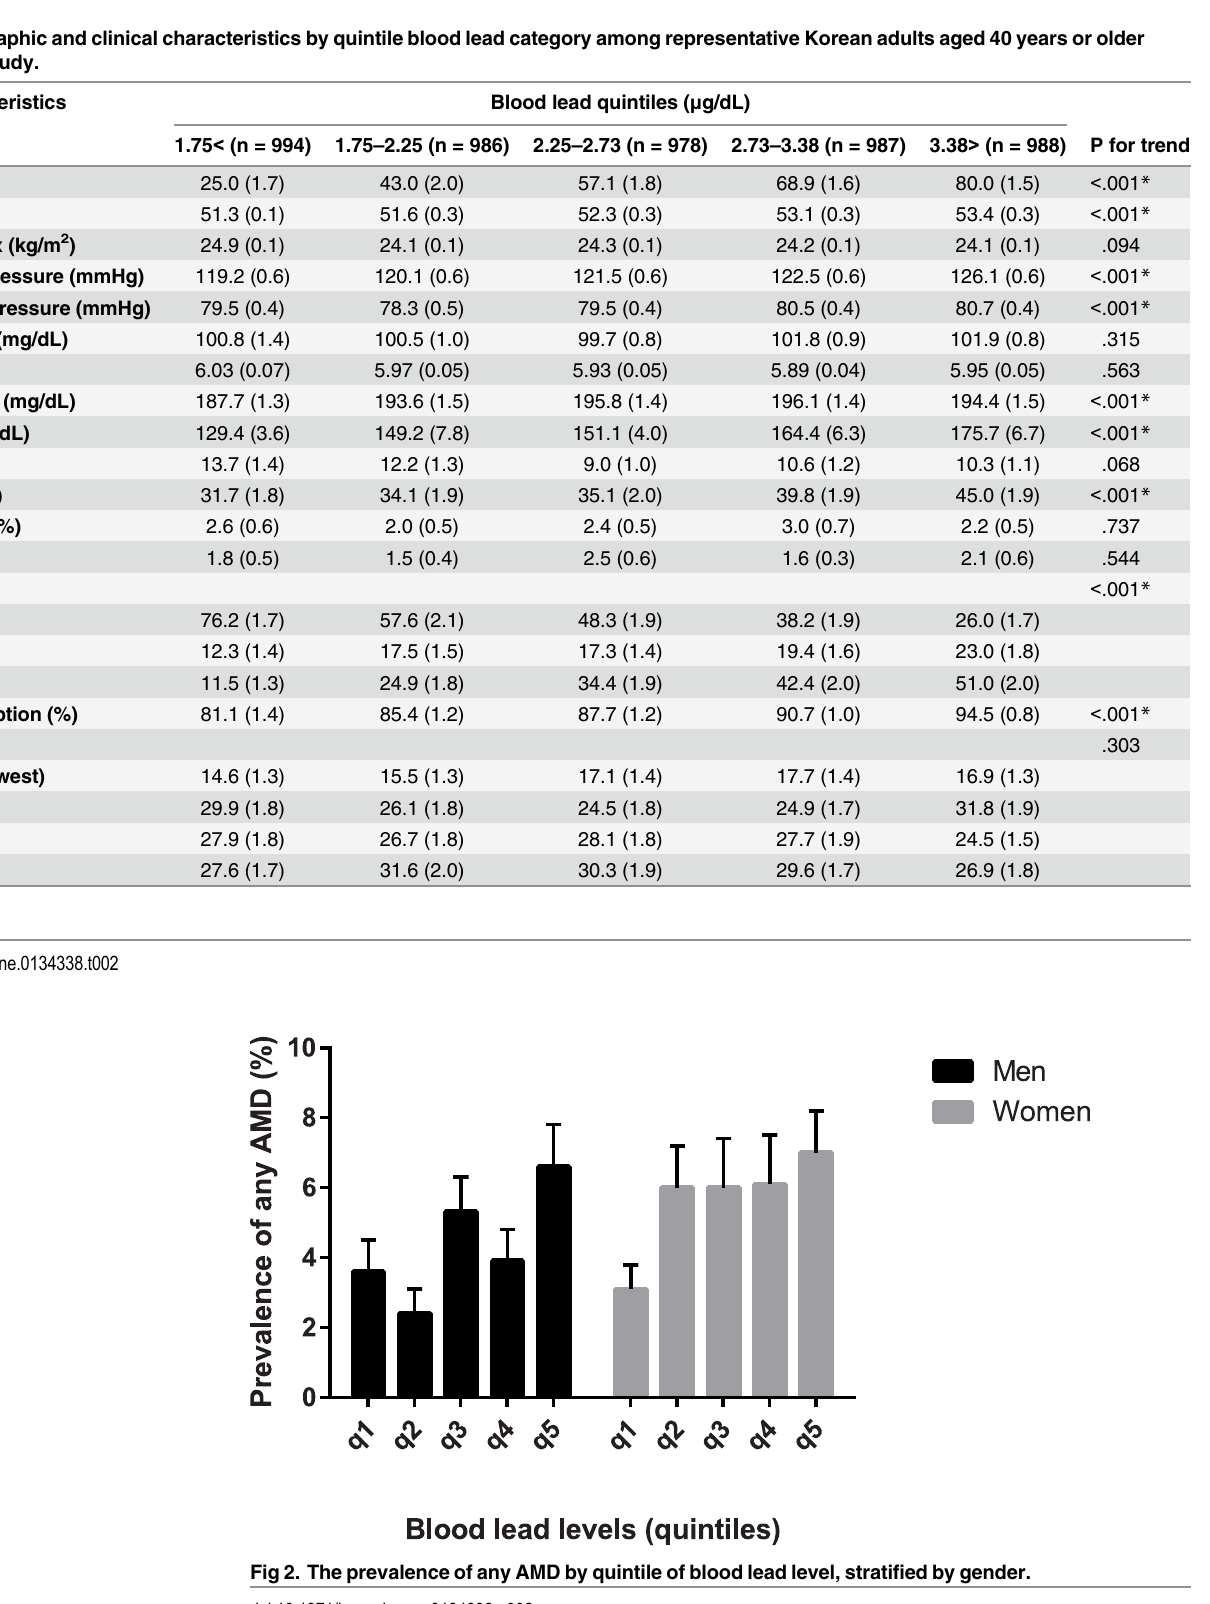
PLOS ONE | DOI:10.1371/journal.pone.0134338 August 7,